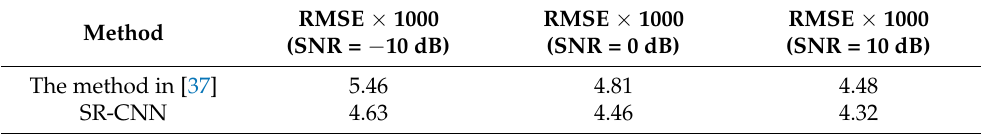
Table 3. Comparison with neural network-based method.